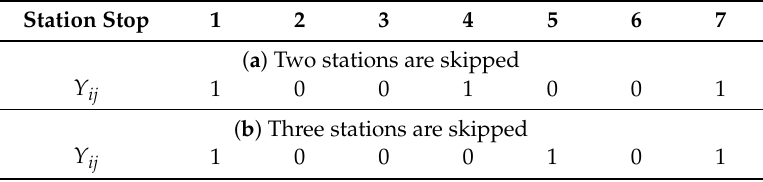
Table 6. Station operating